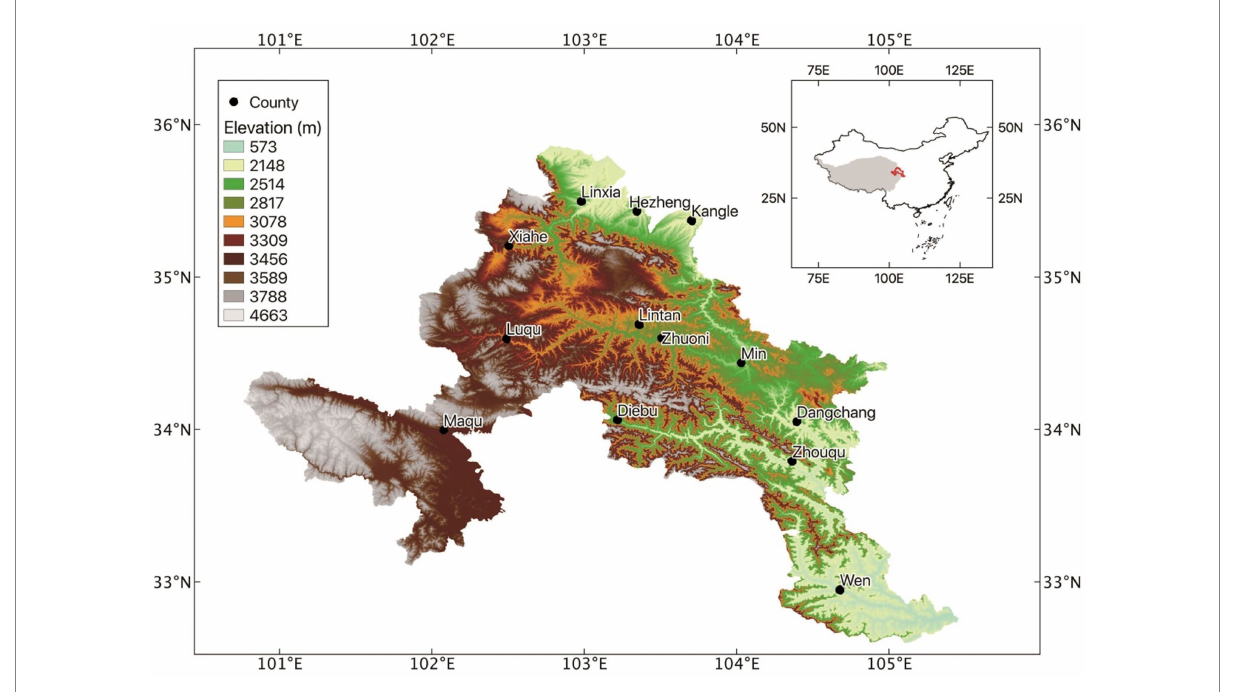
FIGURE 1 The study area and sampling sites along the elevation